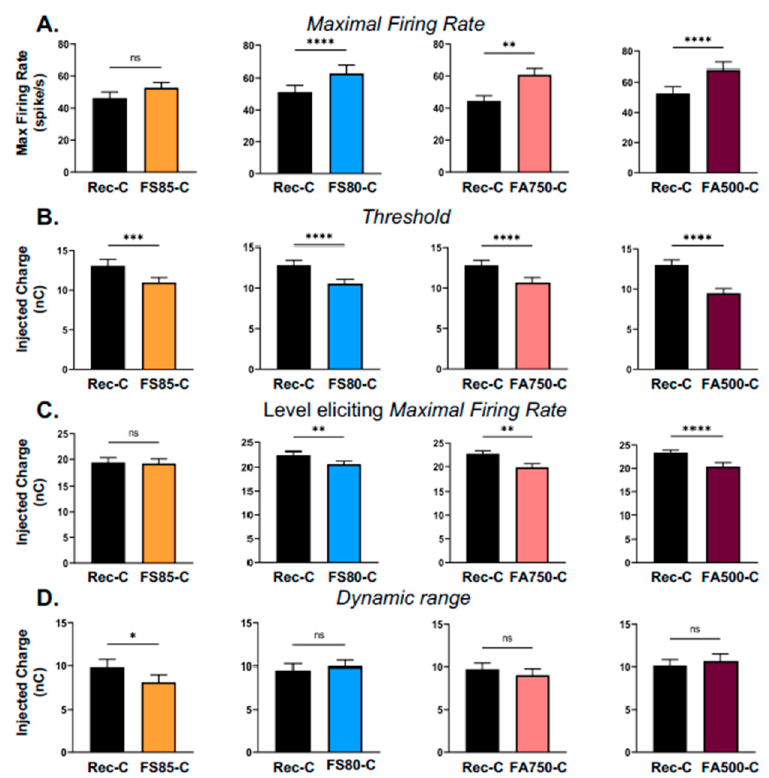
Figure 4. Mean values (± sem) obtained for four parameters of evoked responses with the rectangular pulses and the four types of cathodic-first ramped pulses. For each parameter, statistical comparisons (Wilcoxon tests) were made between the set of recordings tested with the rectangular pulses and with a given shape of ramped pulses. ( A ) The maximal evoked firing rate (MaxFR) was increased when stimulations were performed with the four types of ramped pulses compared to rectangular pulses. This increase was significant for three types of ramped pulses ( p < 0.01 with FS80-C, FA750-C and FA500-C), but did not reach significance with the FS85-C ramped pulses ( p = 0.07). ( B ) The threshold was significantly decreased when stimulations were performed with the four types of ramped pulses compared to rectangular pulses ( p < 0.01 in all cases). ( C ) The charge level at which the MaxFR was observed was decreased when stimulations were performed with the four types of ramped pulses compared to rectangular pulses. This decrease was significant for three types of ramped pulses ( p < 0.01 with FS80-C, FA750-C and FA500-C), but did not reach significance with the FS85-C ramped pulses ( p = 0.8278). ( D ) The dynamic range was not significantly modified when stimulations were performed with three types of ramped pulses compared to rectangular pulses ( p = 0.40, p = 0.31 and p = 0.92 for the FS80-C, FA750-C and FA500-C, respectively). It was significantly decreased with the FS85-C ( p < 0.05). See Table 1 for the mean values (± sem) and the p values. The number of recordings and the numbers of animals involved in each comparison are provided in Table 1. (* p < 0.05; ** p < 0.01; *** p < 0.005; **** p < 0.001; ns: not significant).